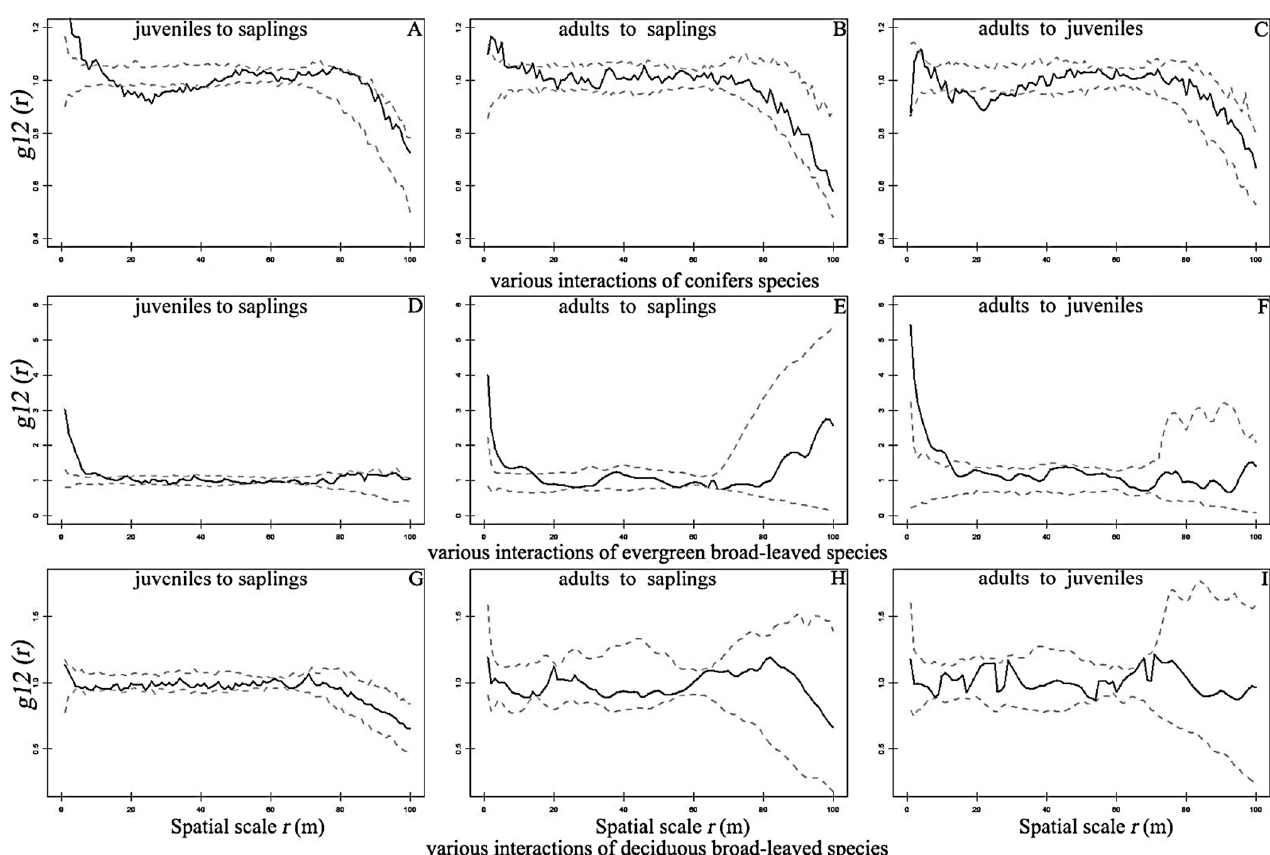
Figure 3. Spatial relationships between broad-leaved species (deciduous and evergreen) and coniferous species among different DBH classes in the mixed forest community Figures are pairwise comparisons between three size classes (saplings as 1 cm ≤ DBH < 5 cm; juveniles as 5 cm ≤ DBH < 15 cm; adults as DBH ≥ 15 cm) of the three different tree types. ( A , D , G ) juveniles to saplings; ( B , E , H ) adults to saplings; ( C , F , I ) adults to juveniles.